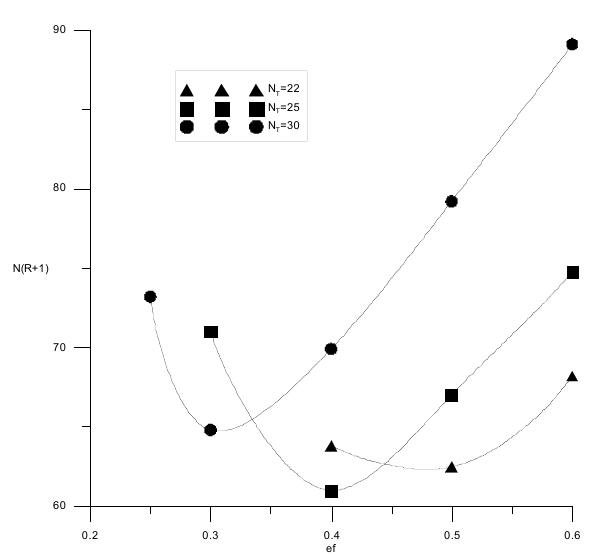
Figure 16. Capital costs for extractive rectification of the trays number in the column at different flow rates of the extractant with a water content of 3 wt %.